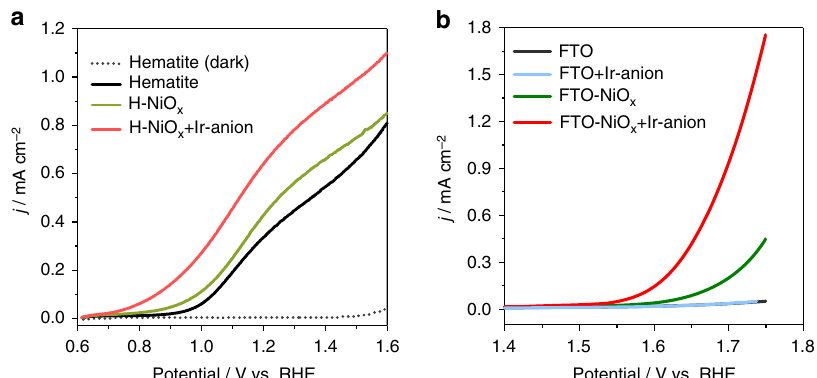
Fig. 3 Catalytic j – V activity. a Linear sweep voltammograms (LSV) on Sn-doped hematite photoelectrodes under AM 1.5 irradiation and b dark FTO electrode at 10 mV s − 1 in 1.0 M